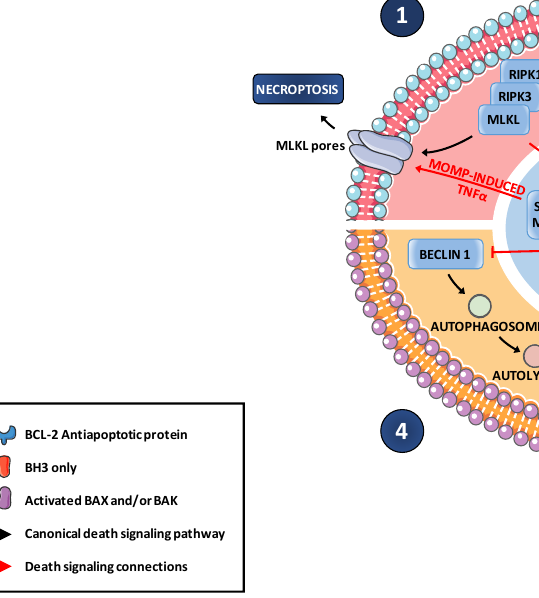
Figure 2. Death signaling crosstalk in tumor cells upon apoptotic caspase activation. 1. Caspase-8 inhibits RIPK1-dependent necroptosis onset. In a caspase deficient context, MOMP-induced release of SMAC-like molecules promotes TNF α -dependent necroptosis. In turn, necroptosis-induced NF- κ B-dependent transcription of PUMA promotes MOMP and mtDNA release. 2. Pore-forming GSDME cleavage by activated caspase-3 connects apoptosis to pyroptosis. Reciprocally, pyroptosis leads to mitochondrial damages through GSDMD accumulation and mPTP-dependent release of ROS release and apoptosis activation. 3. MOMP coincident release of ROS participates in ferroptosis whereas Fe-dependent ROS contributes to cyto-c release. 4. Apoptosis interacts with autophagy signaling via Beclin 1-BCL-2 family anti-apoptotic proteins